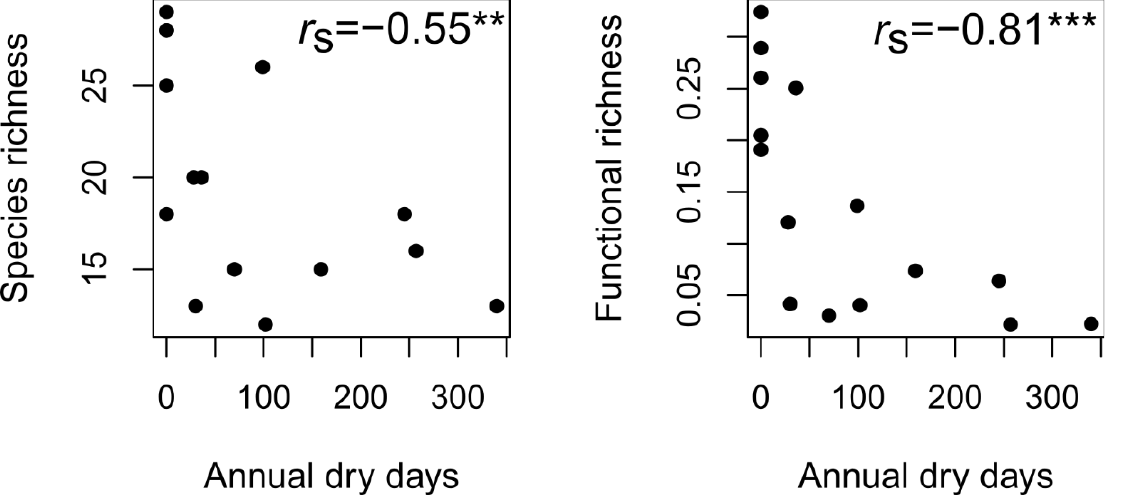
Figure 3. Plots showing the responses of aquatic fungal species functional richness (right panel) and taxonomic richness (left panel) to annual drying duration (annual dry days). Spearman correlation ( r S ) and significance are also shown (**: p -value < 0.05, ***: p -value < 0.01). Functional richness and species showed a positive and significant correlation ( r S = 0.76; p -value: 0.001).